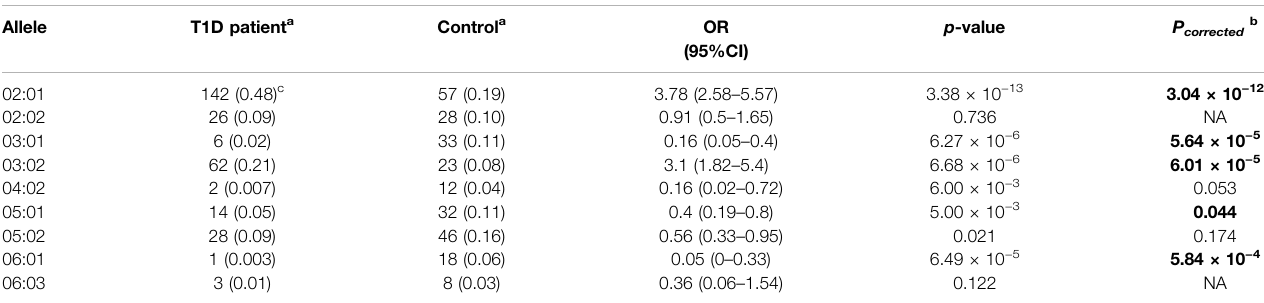
TABLE 3 | Associations of DQB1 alleles with T1D in Emirati study subjects. Allele T1D patient